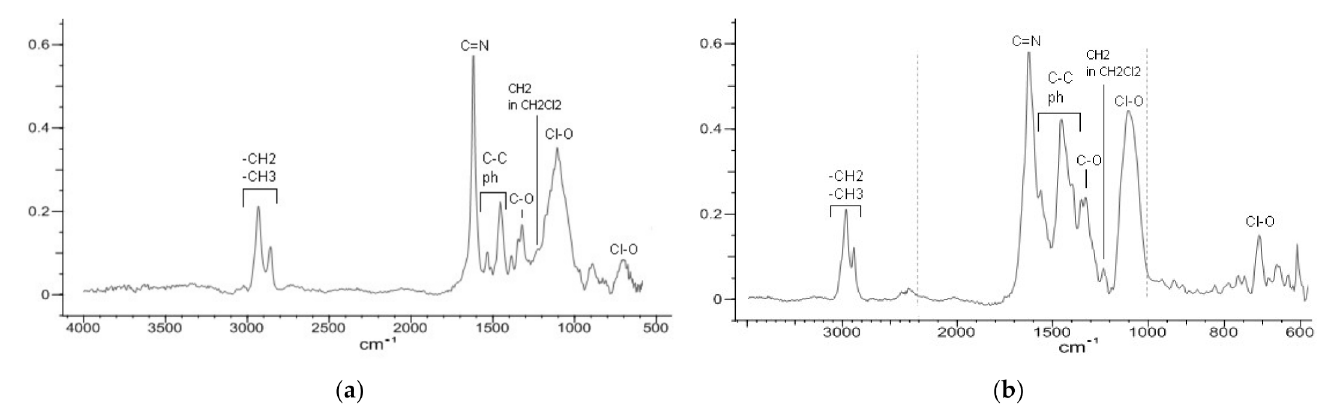
Figure 1. FTIR ATR spectra of poly [Ni(salcn)] electrosynthesized in TBAClO 4 /CH 2 Cl 2 ( v = 0.05 V · s − 1 , 10 cycles, vs. Ag/AgCl), ( a ) neutral, ( b ) oxidized at the anode peak potential, E pa = 0.8 V. In the oxidized film (Figure 1b), bands derived from υ CH 2 and CH 3 (2922(m) and 2881(m) cm − 1 ), υ C=N (1624(s) cm − 1 ) and δ CH 2 Cl 2 (1236(w) cm − 1 ) did not change